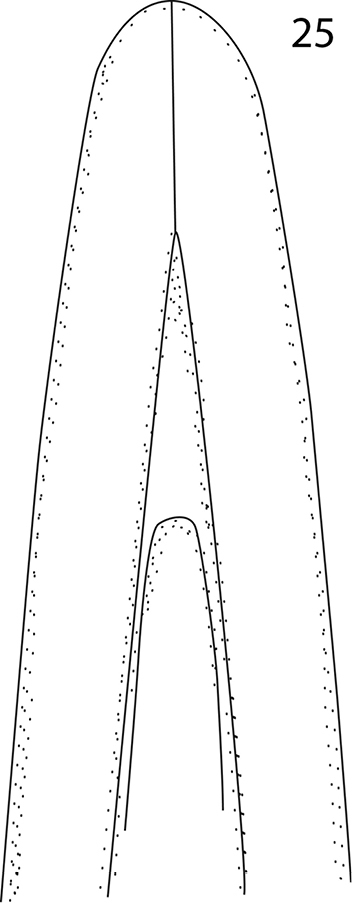
Malagasyprinus perrieri sp. n., apex of aedeagus, re-drawn from Dahlgren (1969).